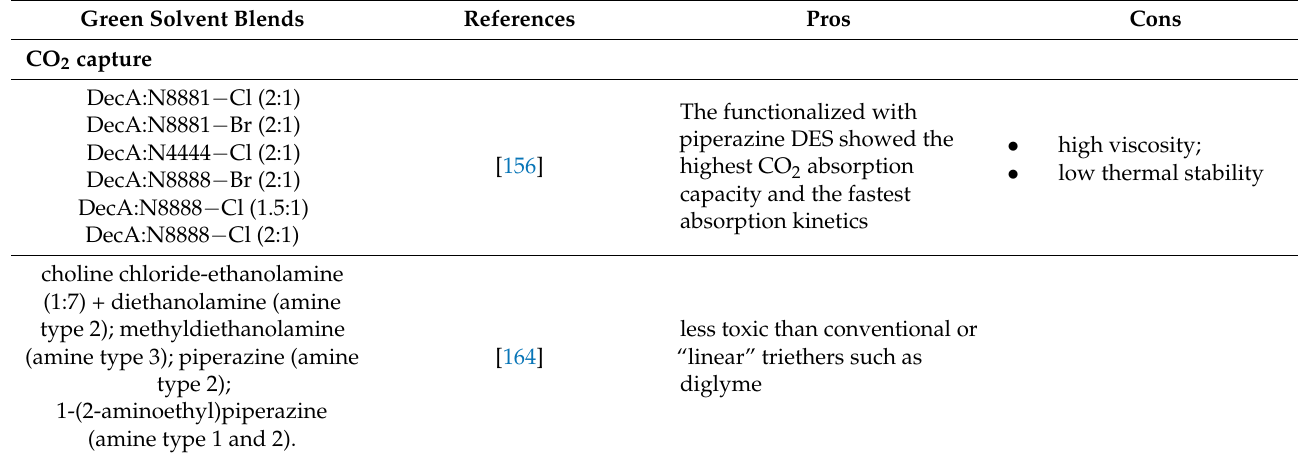
Table 7. Pros and cons of the green solvents studied in the literature, considering both CO 2 capture and H 2 S and CO 2 capture. Green Solvent